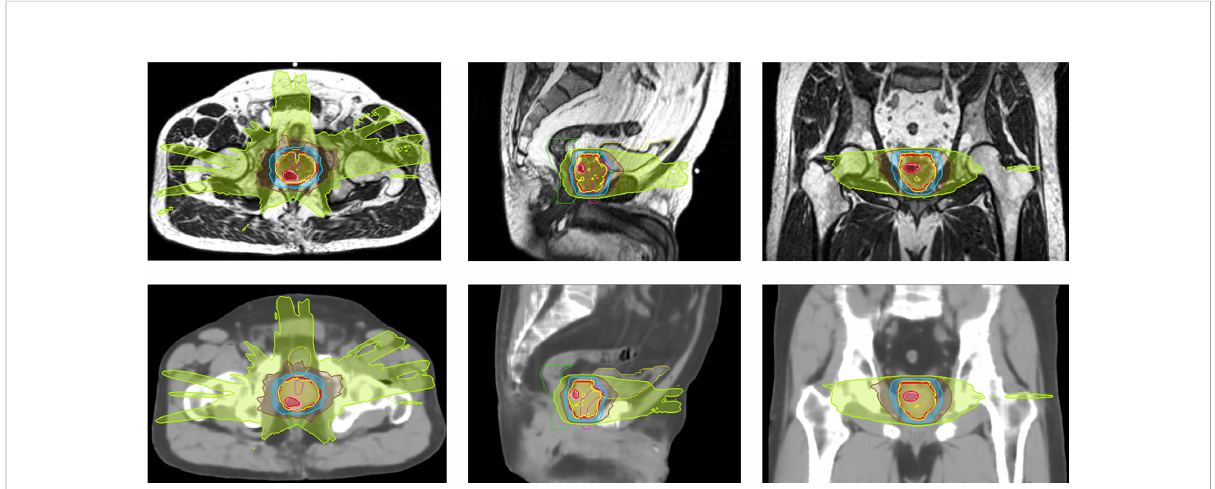
FIGURE 3 Isodose color wash (124%, 100%, 69%, 50% and 30% of 36.25 Gy in the prescribed dose) displayed on MR and sCT ave images in axial, sagittal and coronal views for the best case (SIB